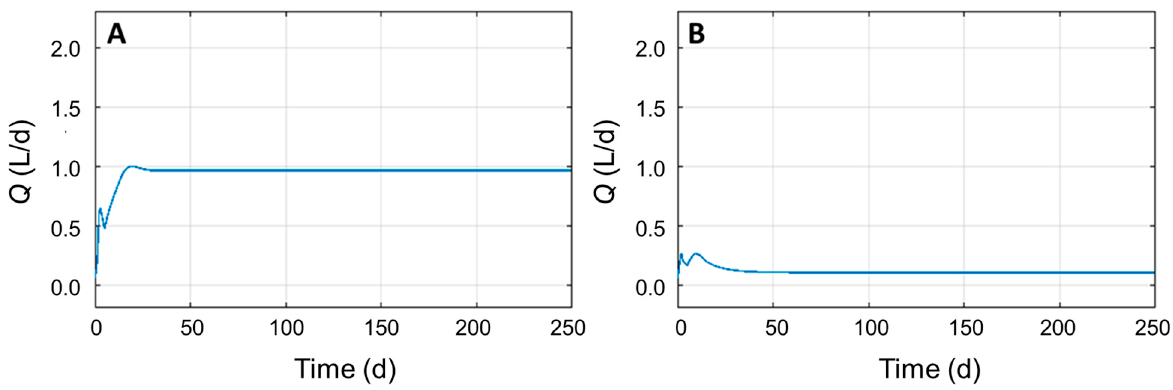
Figure 3. Simulation of biomethane yield ( Q ) over time with updated equations using parameters from [11] (panel A ) and with Y glu/X 1 = 0 (panel B ).